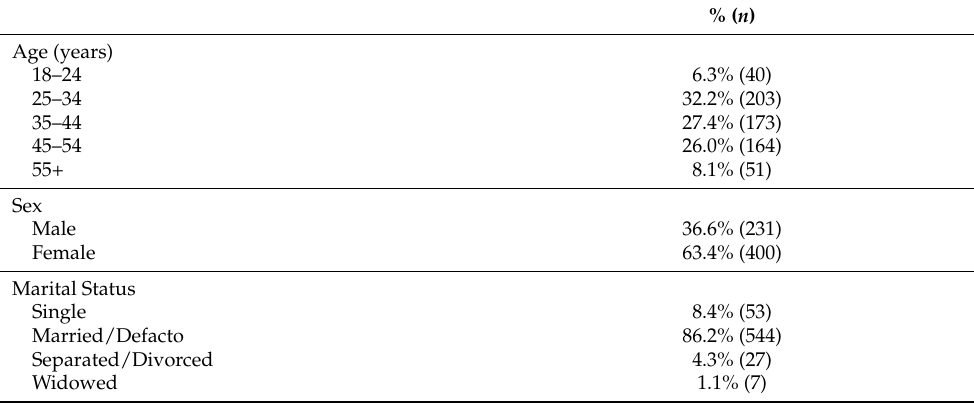
Table 1. Participants’ socio-demographic characteristics ( n =